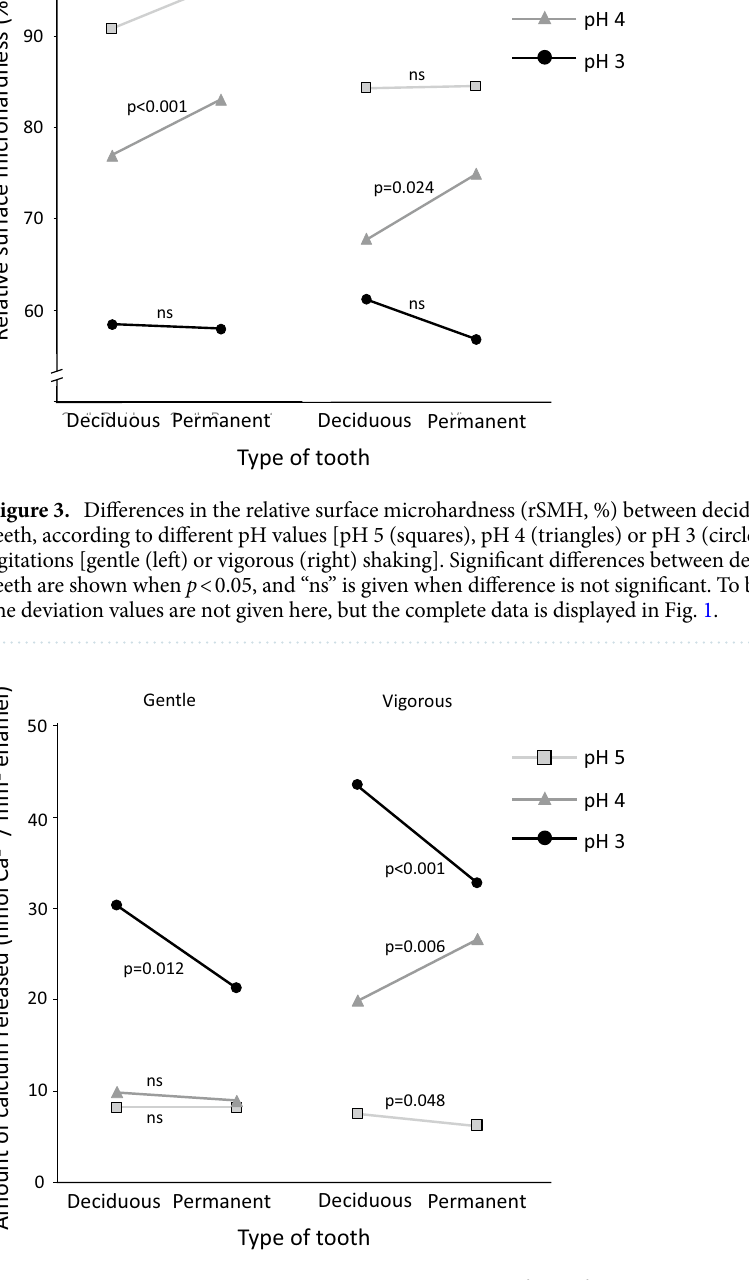
Figure 4. Differences in the amount of calcium (nmol of Ca 2+ /mm 2 of enamel) released from deciduous and permanent teeth, according to different pH values [pH 5 (squares), pH 4 (triangles) or pH 3 (circles)] and different agitations [gentle (left) or vigorous (right) shaking]. Significant differences between deciduous and permanent teeth are shown when p < 0.05, and “ns” is given when difference is not significant. To better visualize the results, the deviation values are not given within this figure, but the complete data is displayed in Fig.